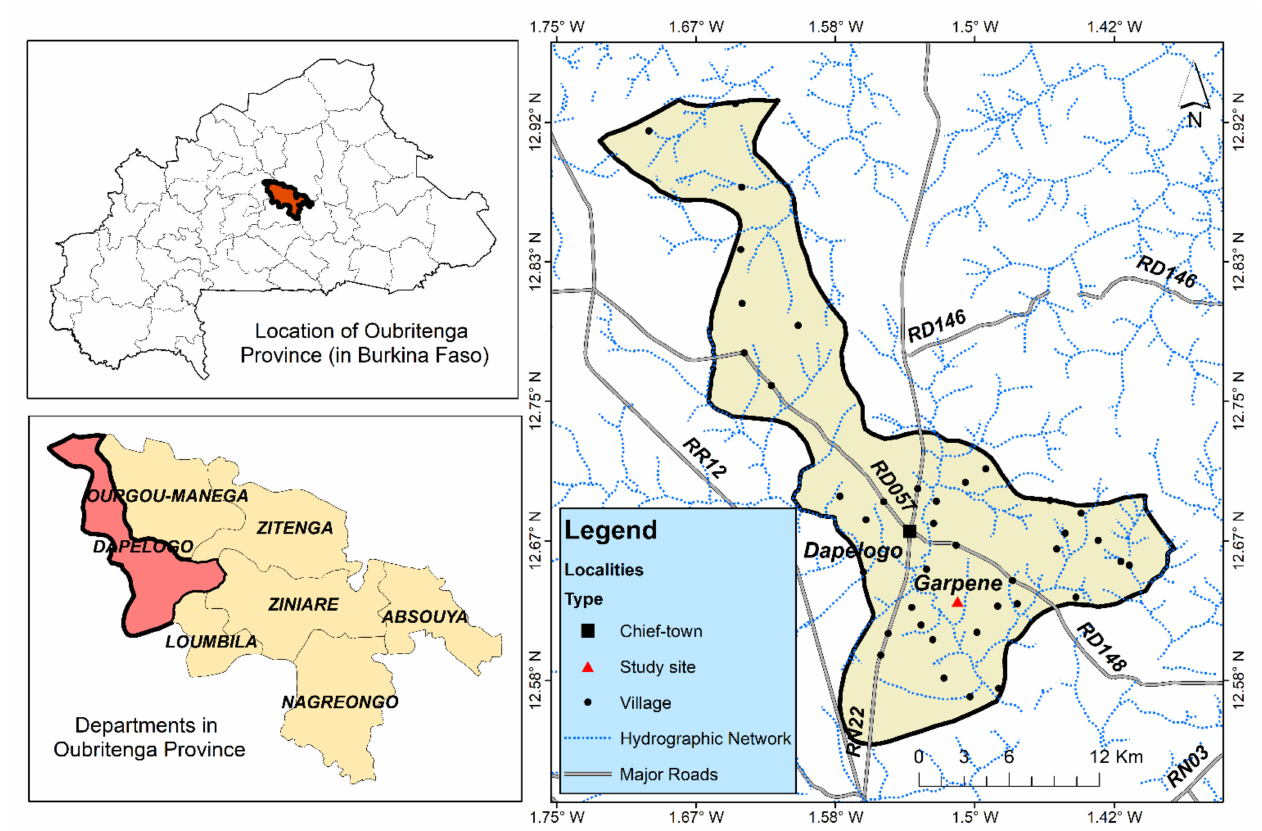
Figure 1. Geographical location of the borehole whose water was used for the